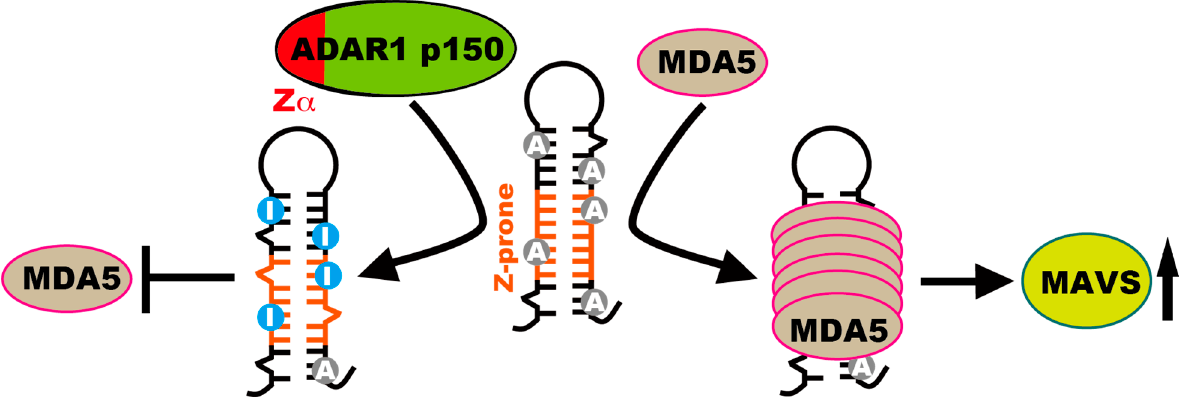
Figure 5. Preventing MDA5 sensing of dsRNAs by ADAR1 p150-mediated RNA editing. ADAR1 p150 binds to Z-prone sequences in dsRNAs through Z α , converting to Z-RNA and promoting adenosine (A)-to-inosine (I) RNA editing of dsRNAs. ADAR1 p150-specific RNA editing is required for prevention of sensing unedited dsRNAs by MDA5, leading to filament assembly and activating MAVS.